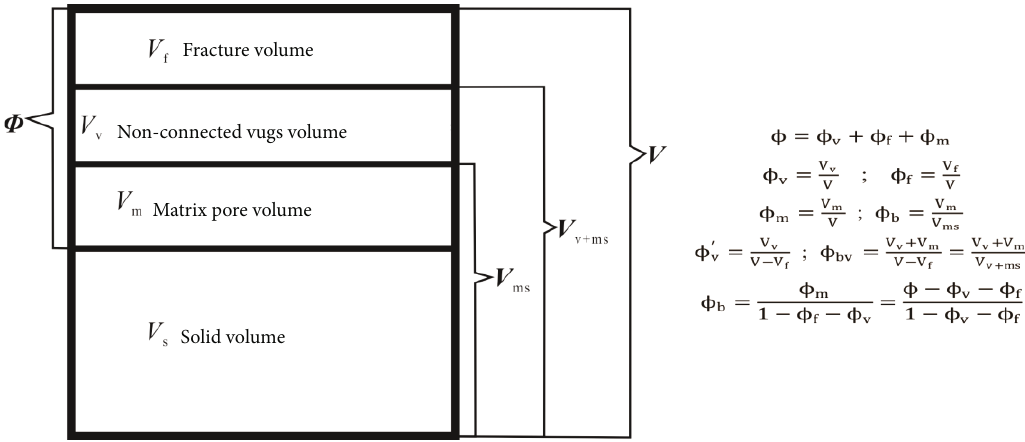
Figure 6: Petrophysical volume model of the triple-porosity medium composite system [20].